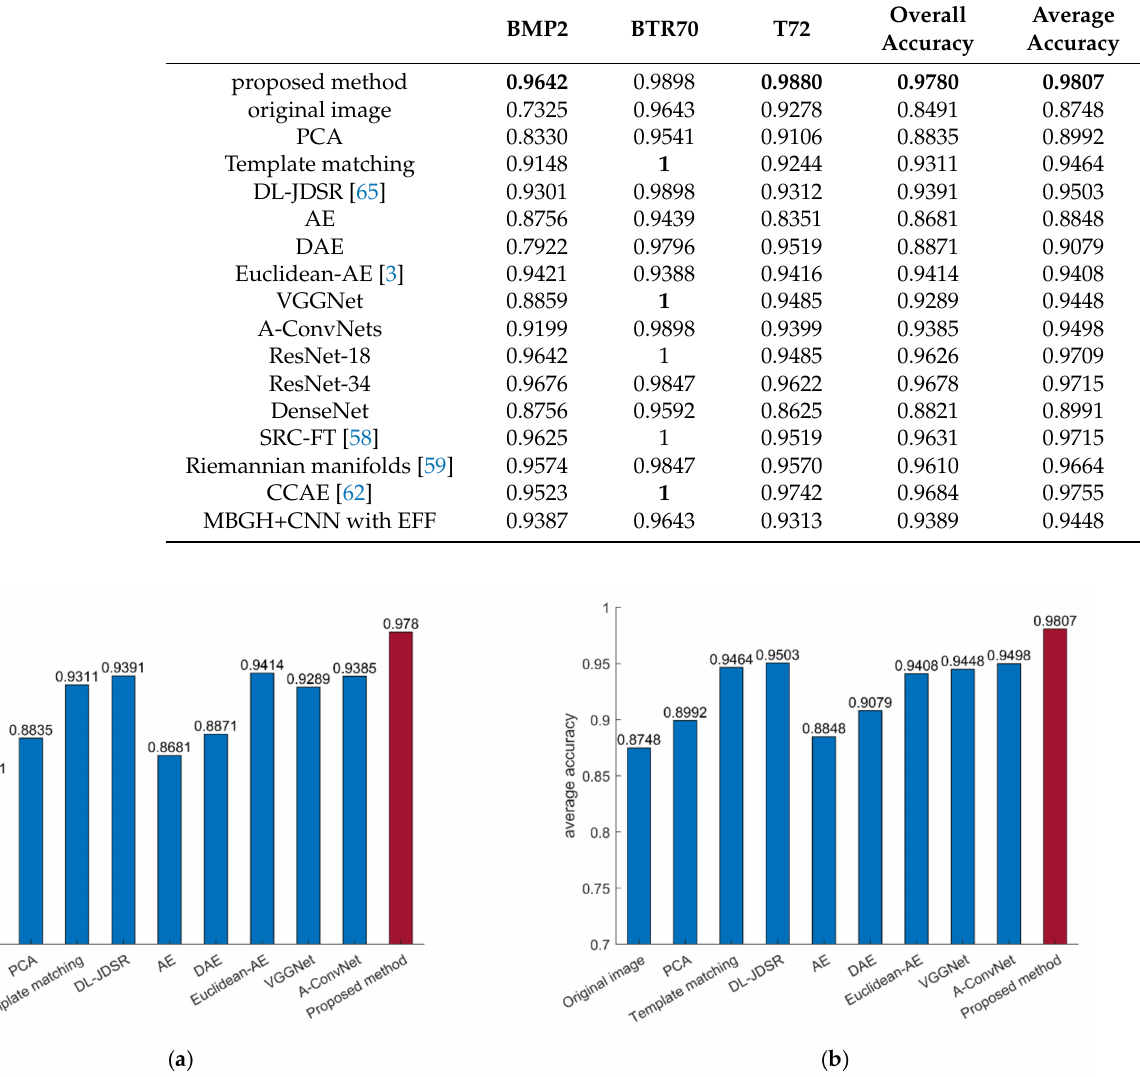
Table 5. Detailed Accuracies of Different Types on The Three-Target Data via Some SAR Recogni- tion Methods.